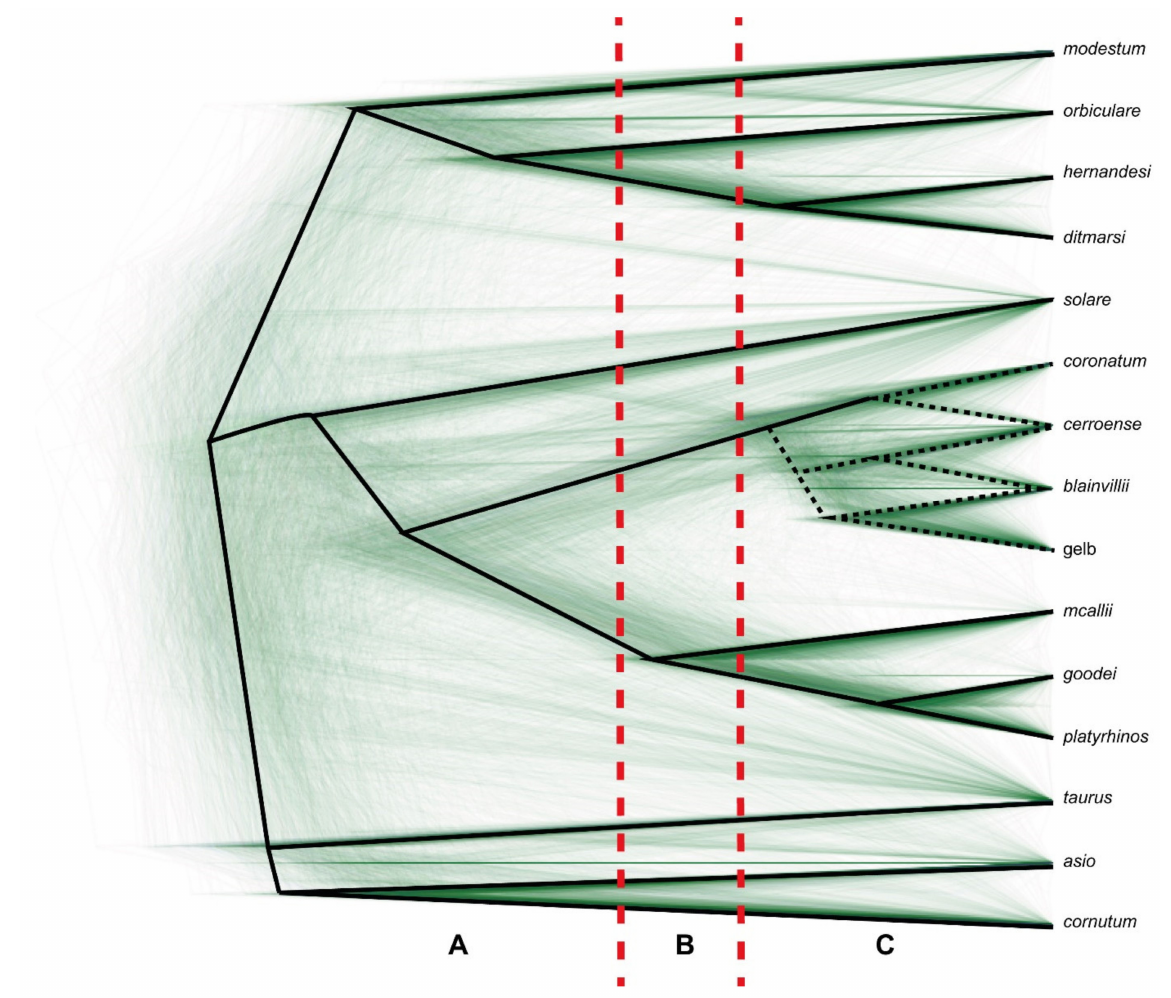
Figure 4. Species tree inferred with BEAST based on the ND2 dataset, showing density of trees proportional to frequency of occurrence, drawn in DensiTree. The vertical dashed red lines roughly indicate the percentage difference defining my categories A, B, and C (see text for